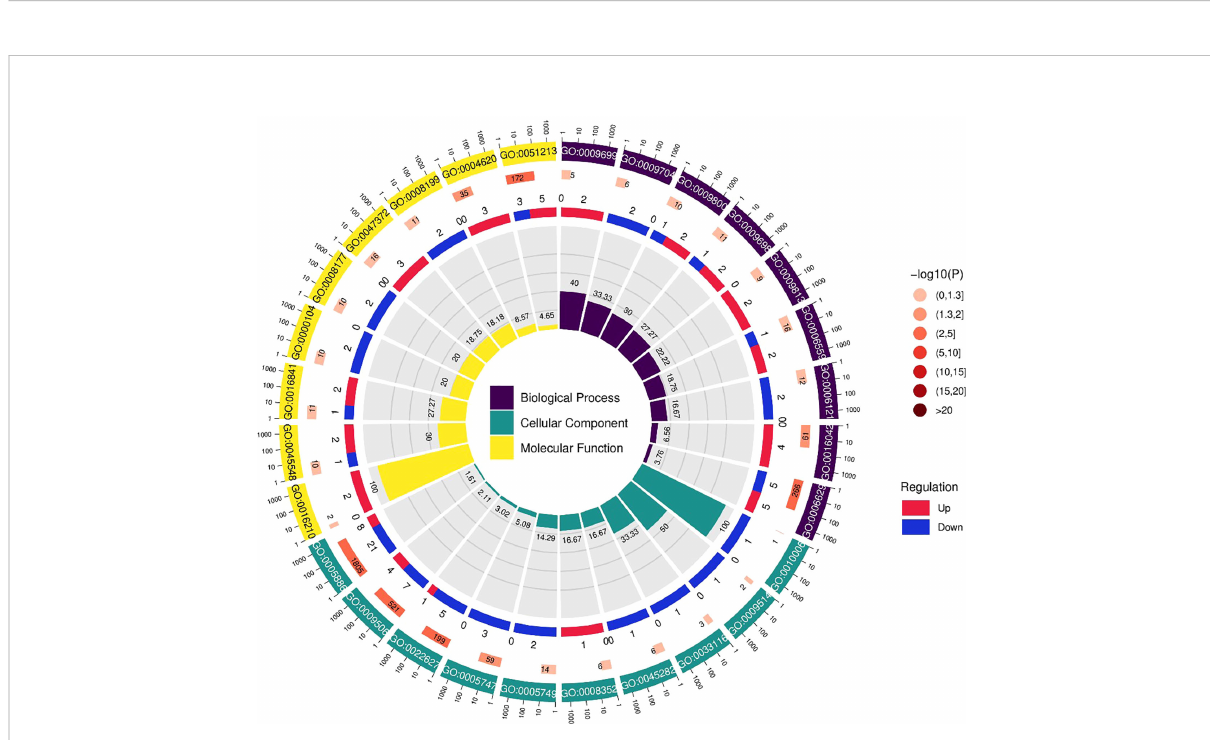
FIGURE 2 KEGG enrichment axial plot shows the DEG enrichment analysis results in the KEGG pathway.